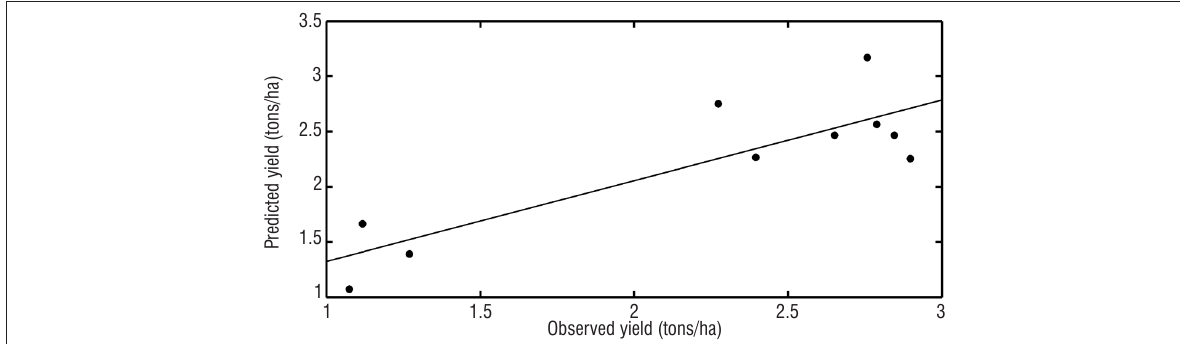
Figure 2: Central Free State predicted wheat yield as a function of observed wheat yield.